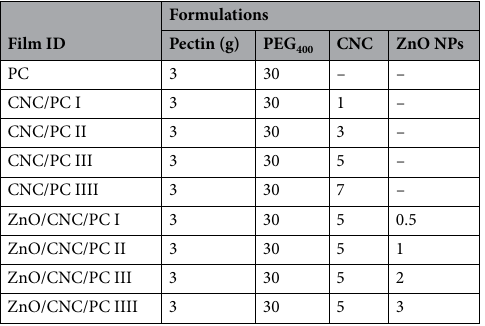
Table 1. Formulations of the prepared films. PEG400, CNC and ZnO NPS are added as % (w/w) of pectin per 100 mL solution.